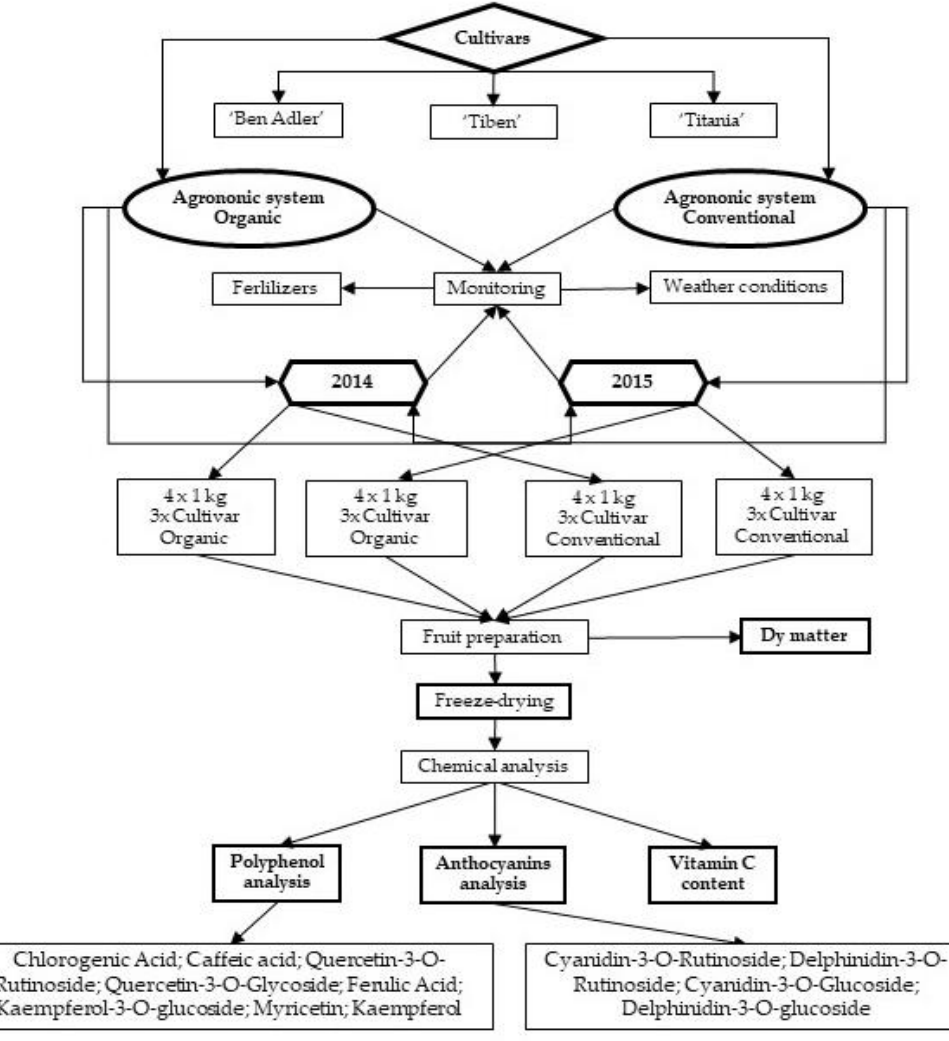
Figure 1. Graphical scheme of study design.